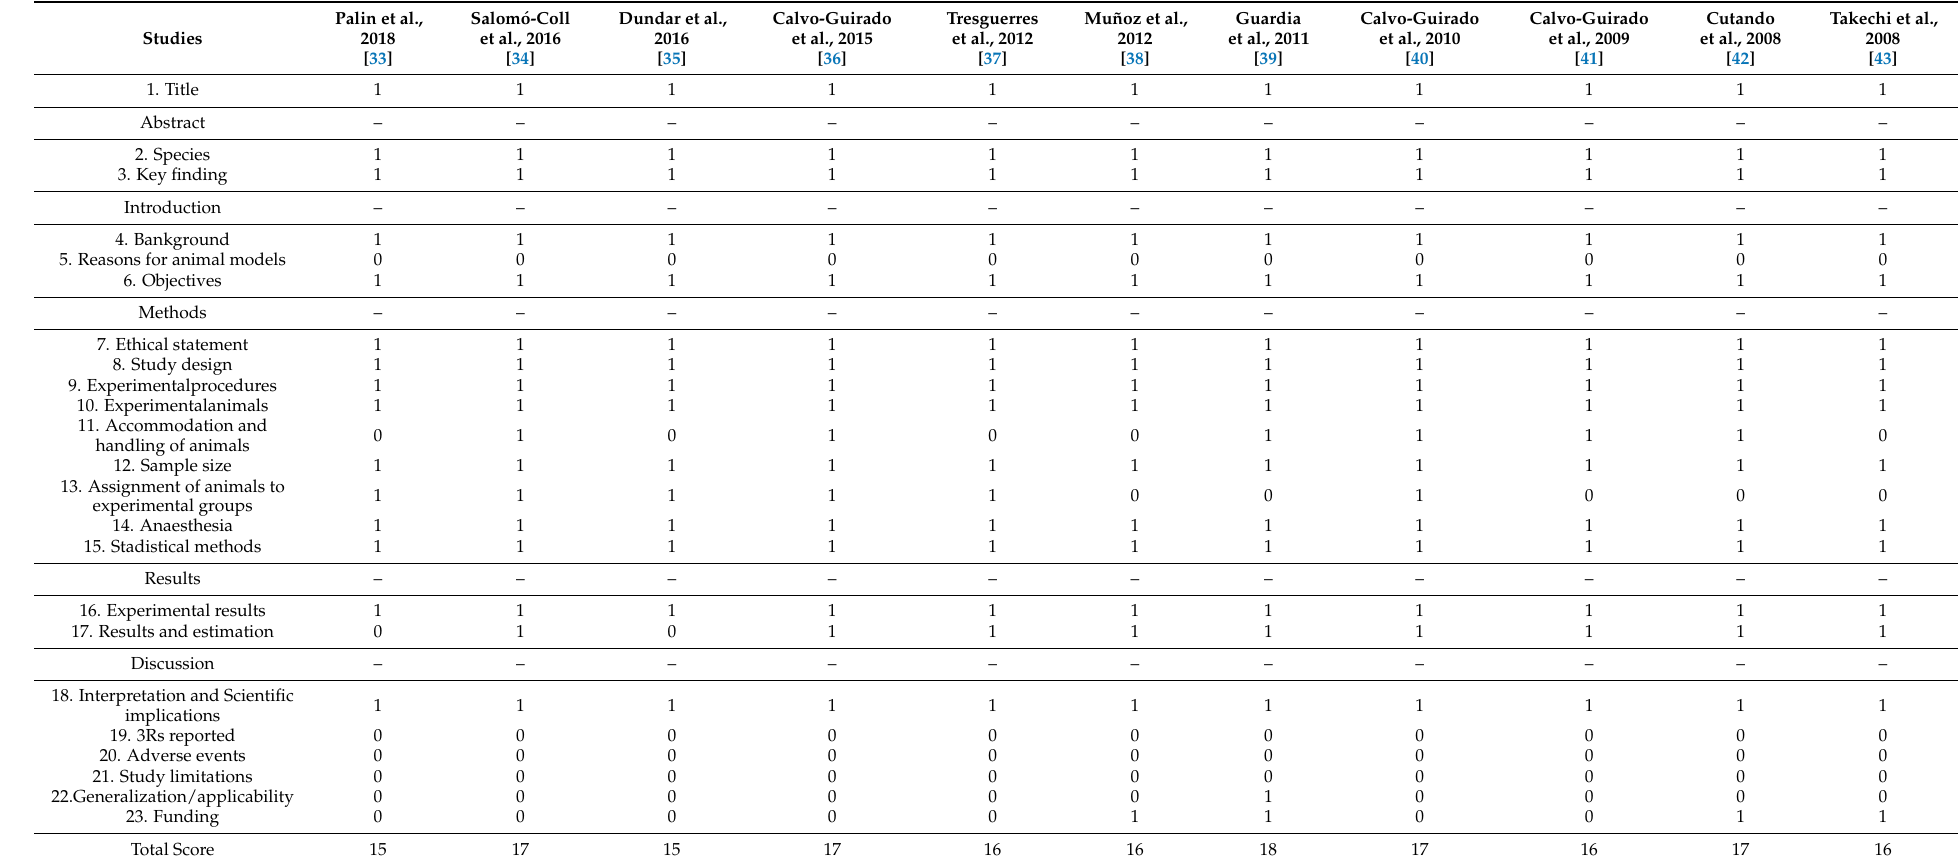
Table 1. Checklist of ARRIVE criteria reported by the included